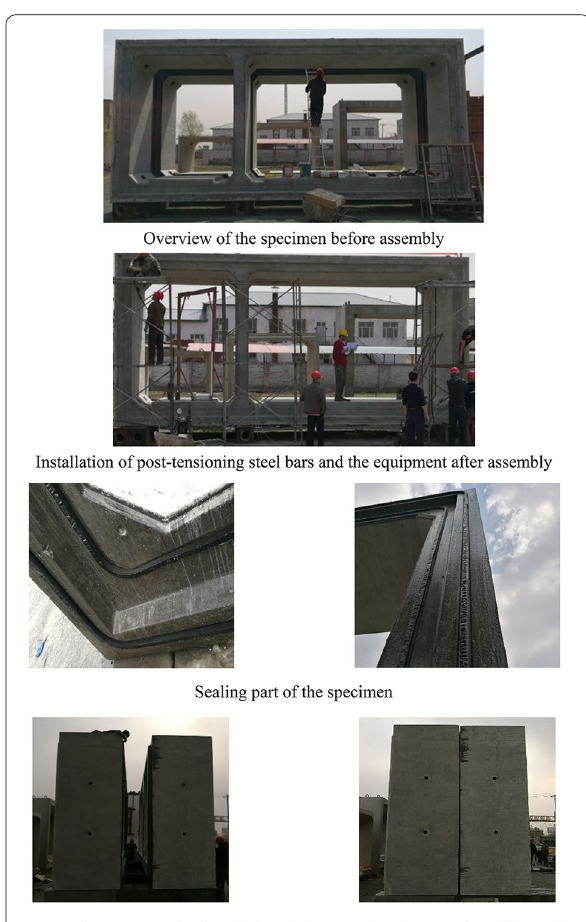
Fig. 6 Full‑scale waterproofing tests using the putty‑based composite rubber